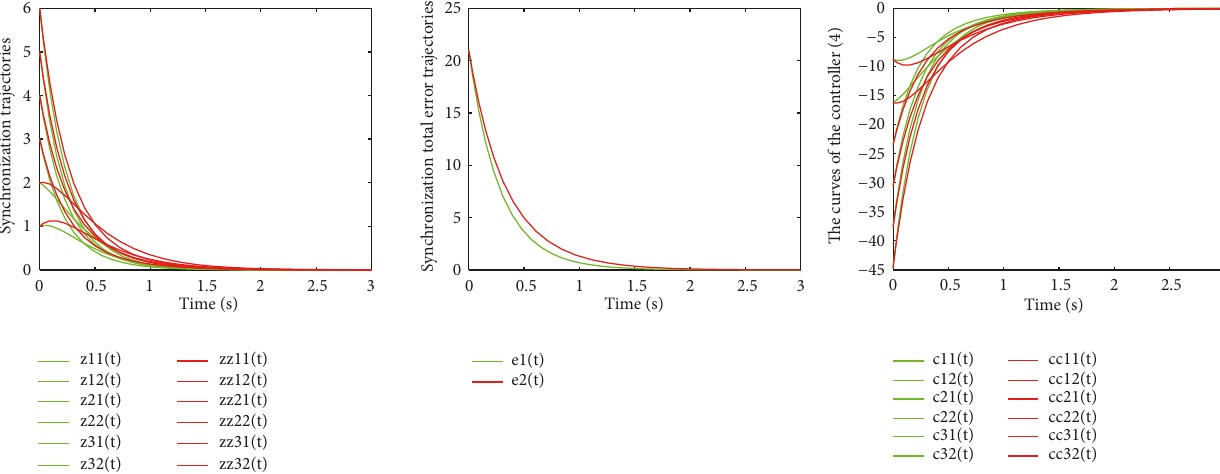
Figure 5: Synchronization trajectories, synchronization total error trajectories of networks (1) and (2) with controller (4) and the curves of controller (4) for Case I-1 of Example